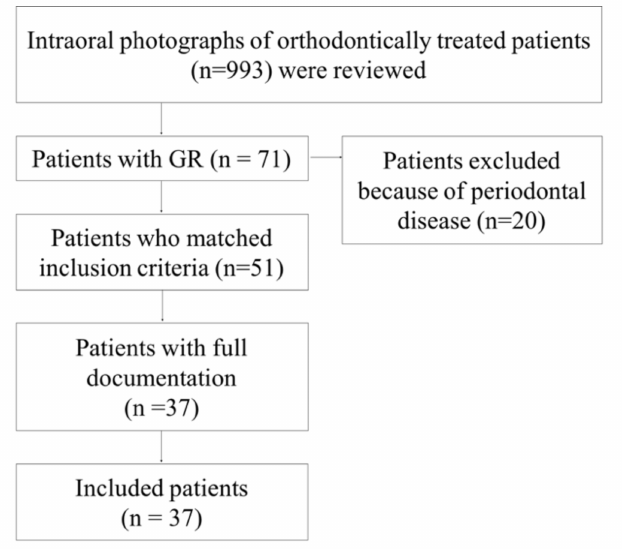
Figure 1. Flowchart of included patients with gingival recession. Patients were treated by two orthodontists (authors EZ and DS) in the Department of Orthodontics, Faculty of Odontology at Lithuanian University of Health Sciences (LUHS) and the private practice in Kaunas, Lithuania. The presence of GR was identified on frontal, right and left buccal intraoral photographs (in occlusion) by one investigator, who was blinded (GA). The diagnosis was confirmed in patients’ records and then measured on the plaster models (Figure 2).